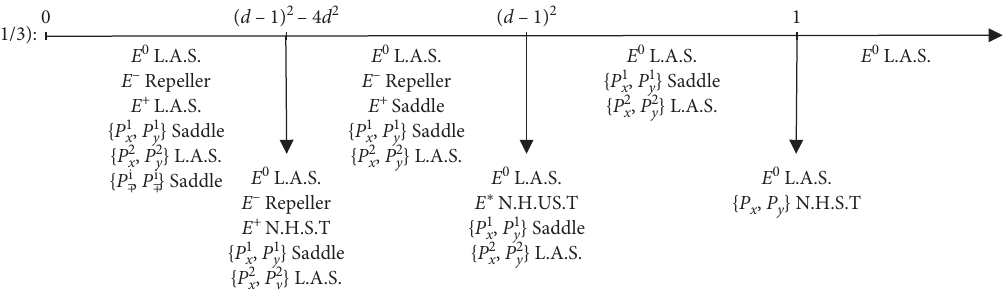
Figure 1: Bifurcation diagram of global dynamics of equation (1) in the parametric region d < 1/3 for different values of the bifurcation parameter 4 fc .